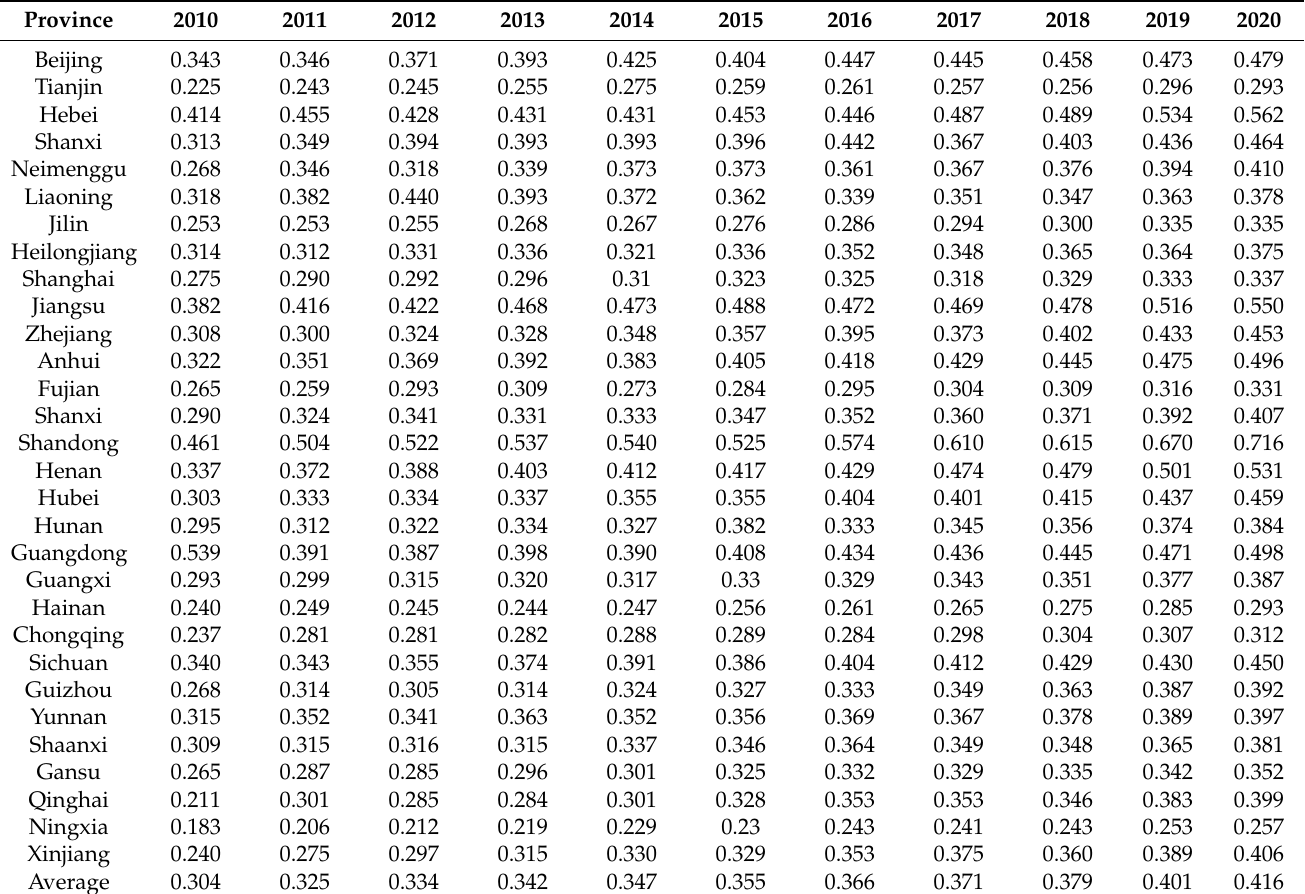
Table 2. Comprehensive evaluation results of a green economy.